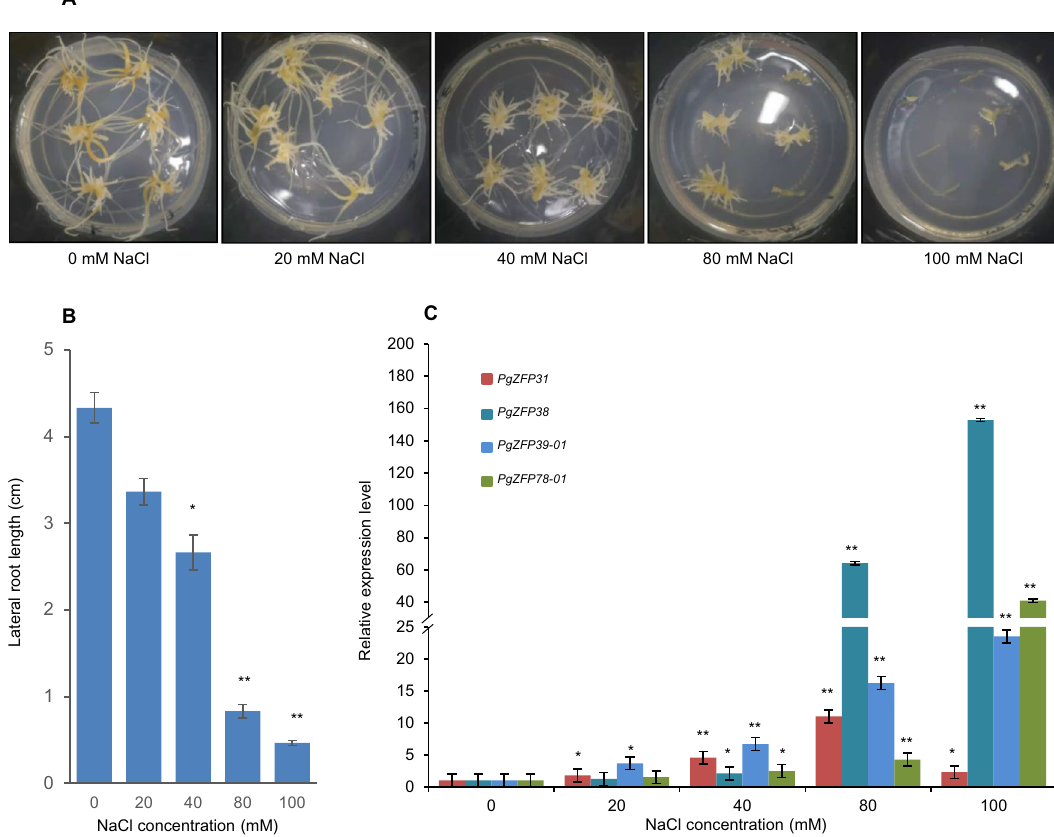
Figure 7. The responses of the PgZFP gene family to salt stress. ( A ) Ginseng adventitious roots stressed with different concentrations of NaCl on the B5 medium for 30 days. ( B ) Variation of the lateral root length of the salt-stressed roots. ( C ) The relative expressions of the PgZFP genes selected from the gene family in the salt- stressed roots. The expressions of the genes in the roots stressed with salt were presented as the expression level relative to those of the genes in the roots without salt stress (0 mM NaCl) considered as “1”. The t -test was used to test the mean difference of the gene expressions between control and salt-stressed roots. “*”, significant at P ≤ 0.05; “**”, significant at P ≤